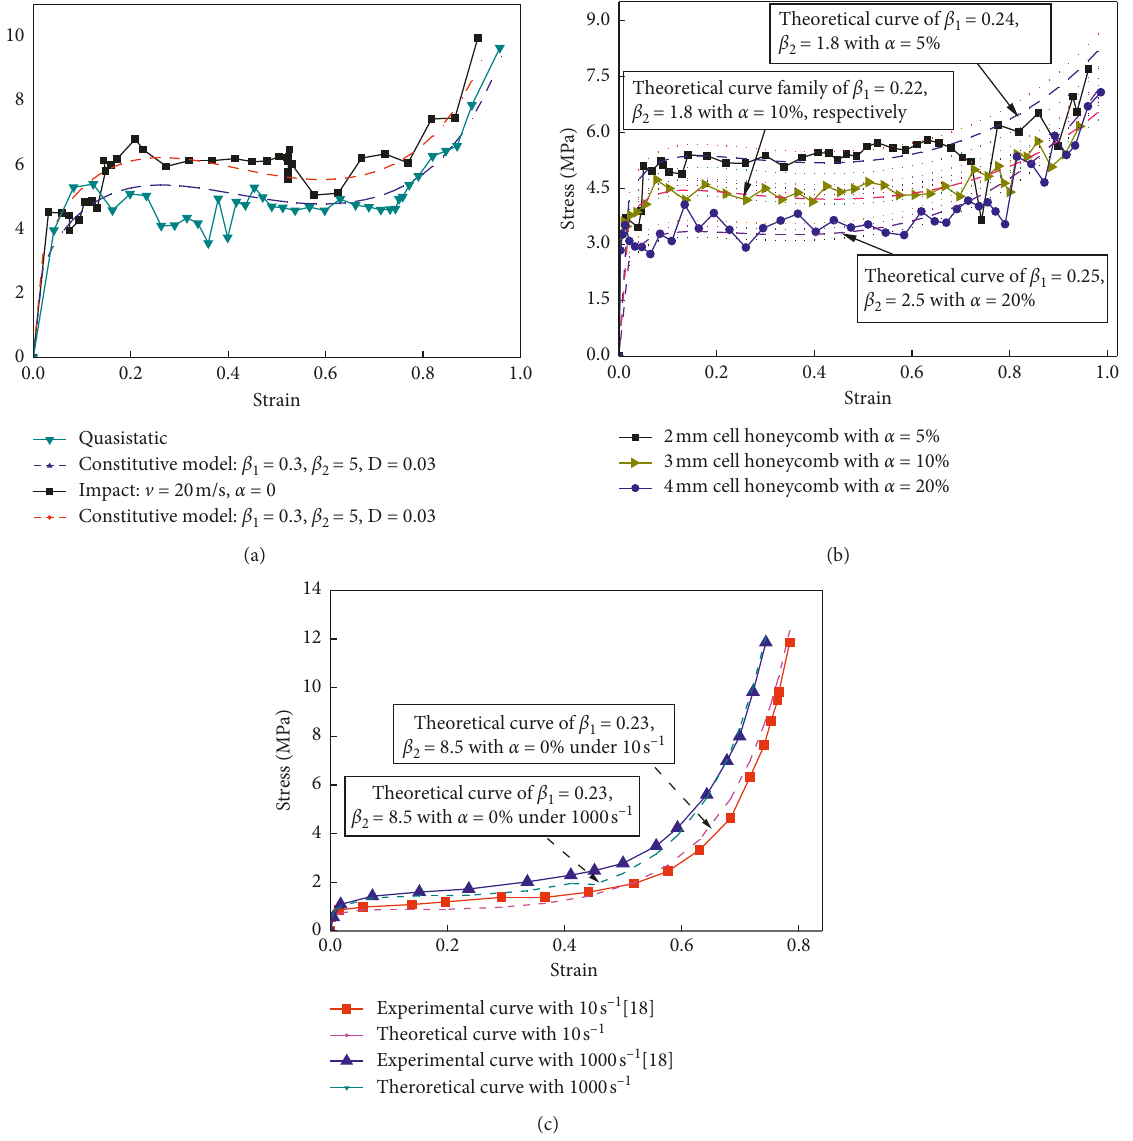
Figure 12: Stress-strain curves and its constitutive model: (a) the stress-stain curves of honeycomb without defects; (b) the stress-stain curves of honeycomb with, random defects under 20m/s impact loading; and (c) experimental and theoretical curves of open-cell metal foam under various strain